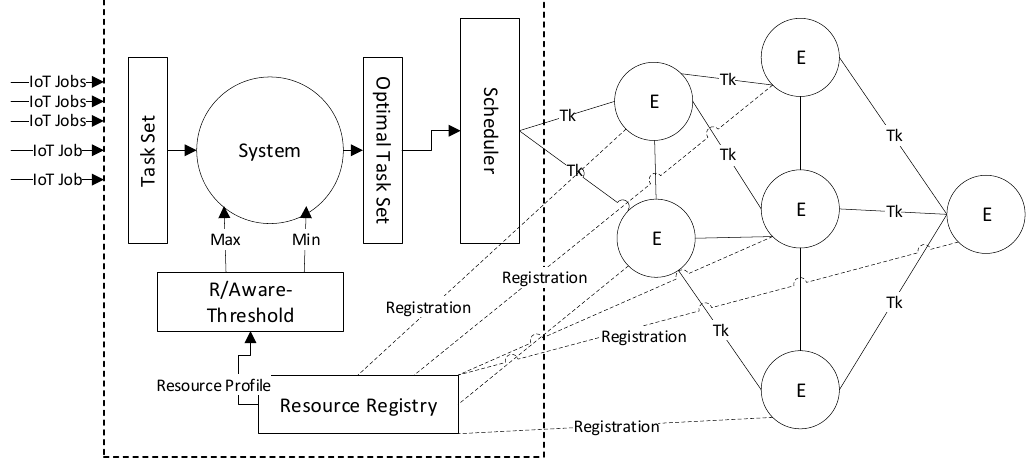
Figure 1. General System block representation of the proposed